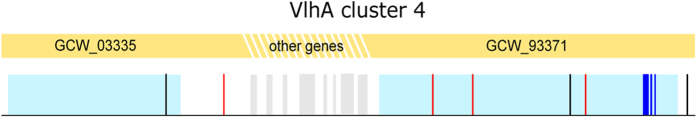
Distribution of SNPs localized in the VlhA cluster 4 genes in MIEC after acute (24 h) and chronic (7 weeks) infections.Lines indicate location of SNPs detected in M. gallisepticum isolated from HD3 cells. Black line-acute infection; blue line–chronic 7-week infection; red line–both acute and chronic 7-week infection.